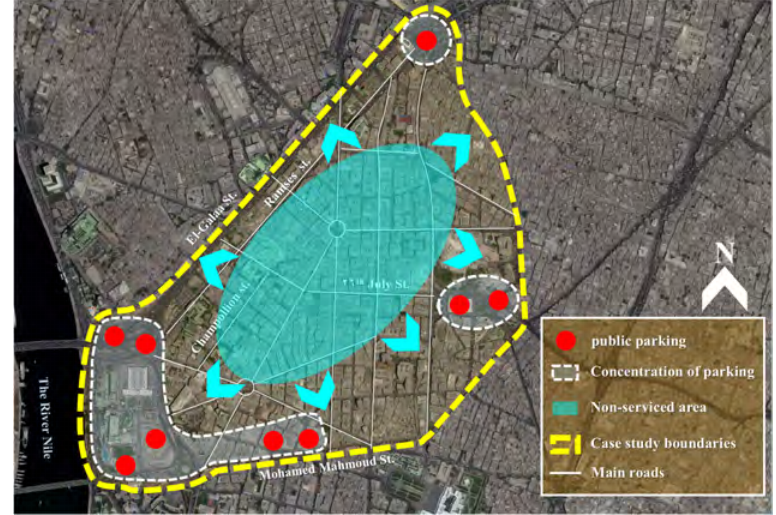
Figure 16. Parking geographical distribution analysis